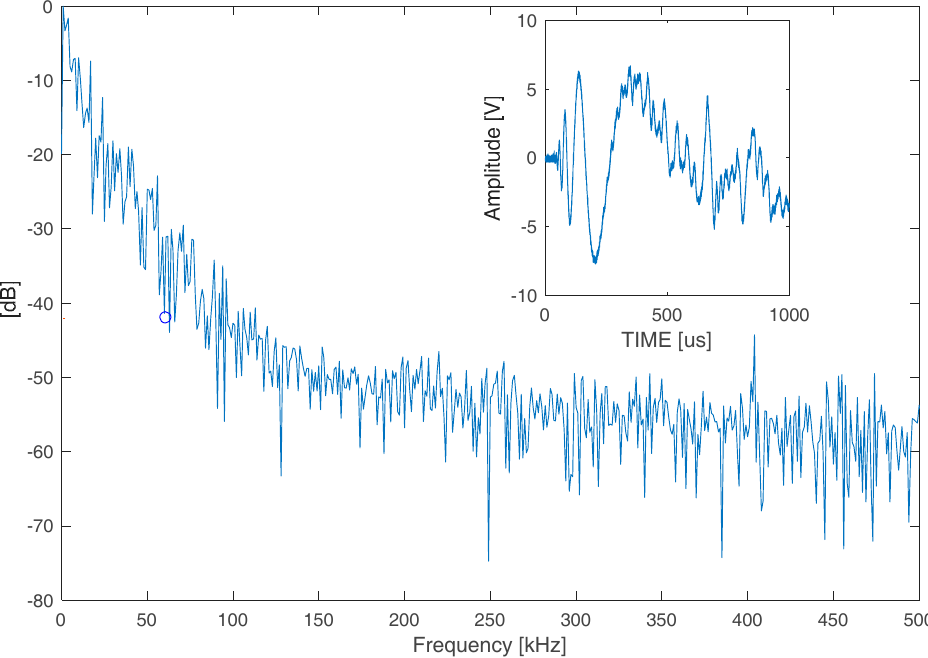
Figure 4. Frequency spectrum of a signal generated by a single impact on the aluminum plate.